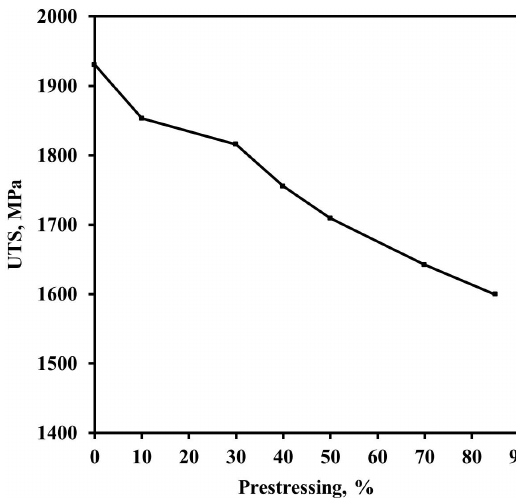
Figure 5. The UTS decrease in the plasma-hydrogenated prestressing steel wire samples to various